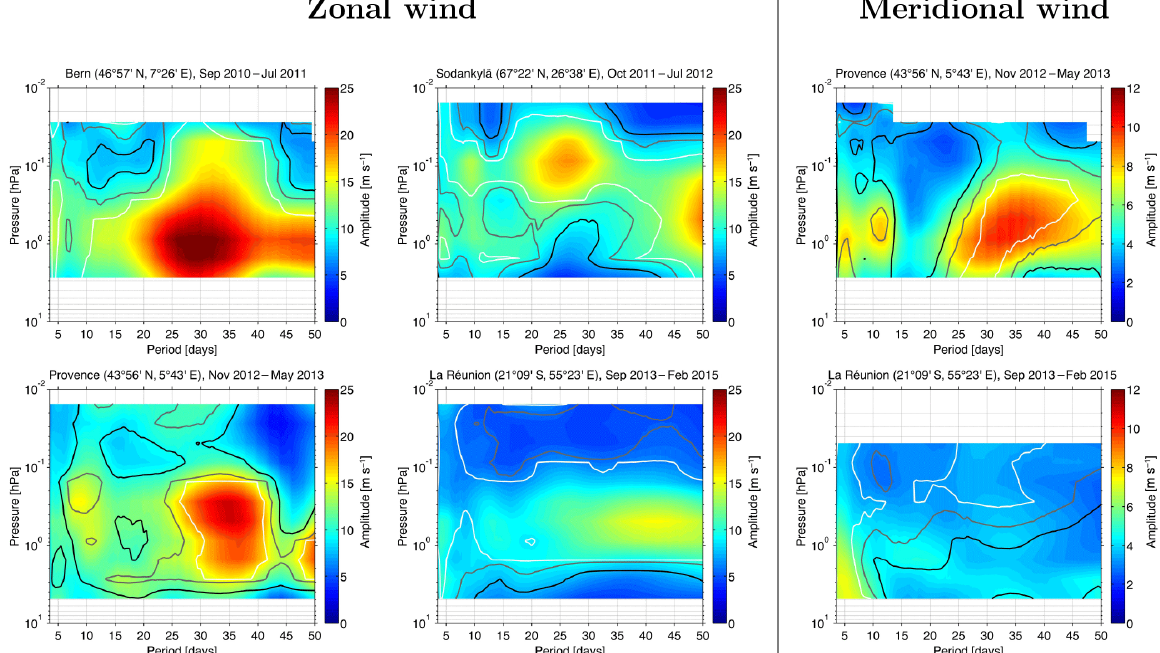
Figure 2. Temporally averaged periodograms of zonal and meridional wind profiles measured by WIRA. The black, gray and white contour lines mark α = 0 . 5, 0.1 and 0.01, where the lowest value, i.e., the white contour, corresponds to the highest significance. The values of α were calculated from Eqs. (5) and (6) based on the average oscillation amplitude and the noise of the entire wind measurement time series determined using the Allan standard deviation (detrended version of the standard deviation; e.g., Allan, 1966). The white areas represent altitudes and periods (i.e., window widths) for which the conditions of Eq. (4) are not satisfied, i.e., for which WIRA cannot provide reliable information due to an insufficient number of data